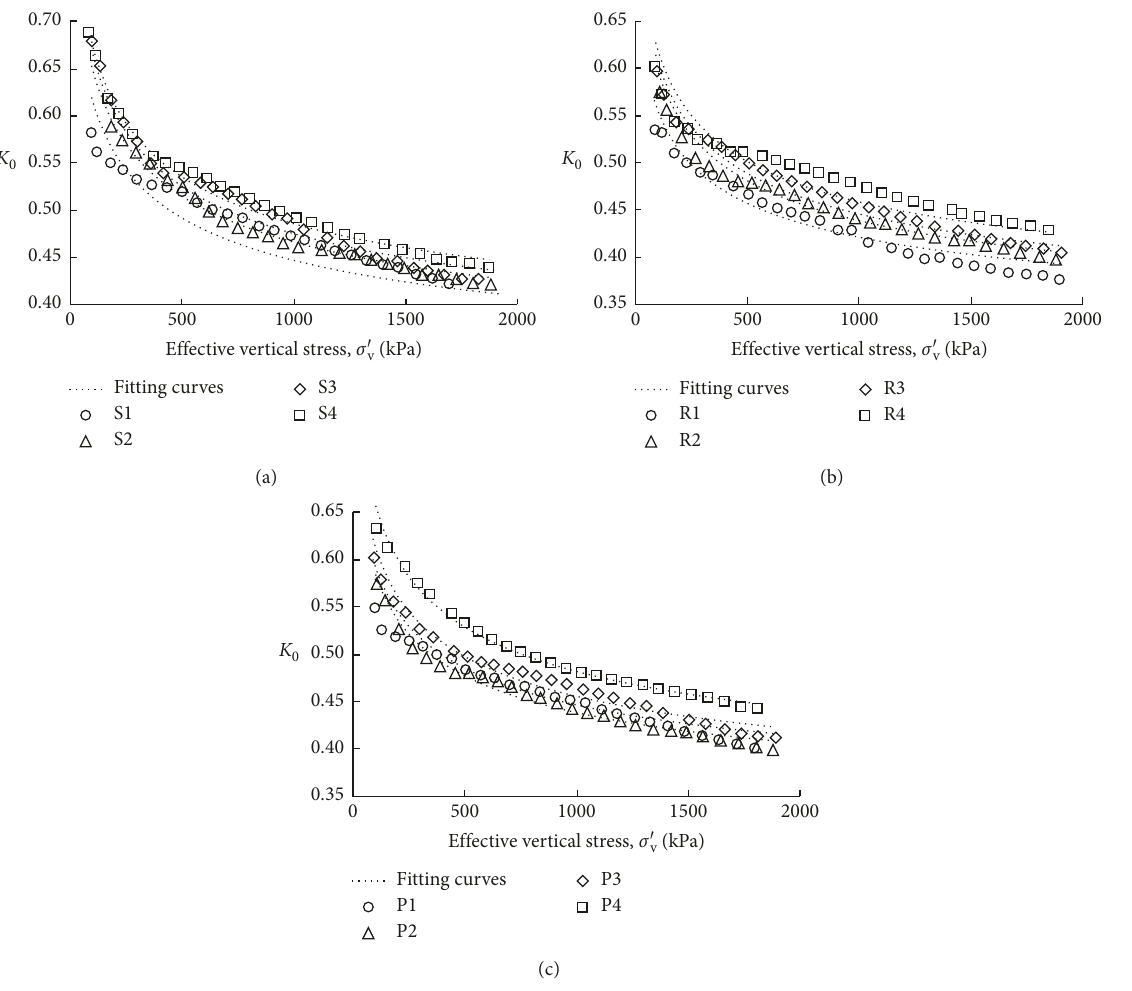
σ v curves. (a) S1 ∼ S4, (b) R1 ∼ R4, and (c) P1 ∼ P4. 0 ′ −